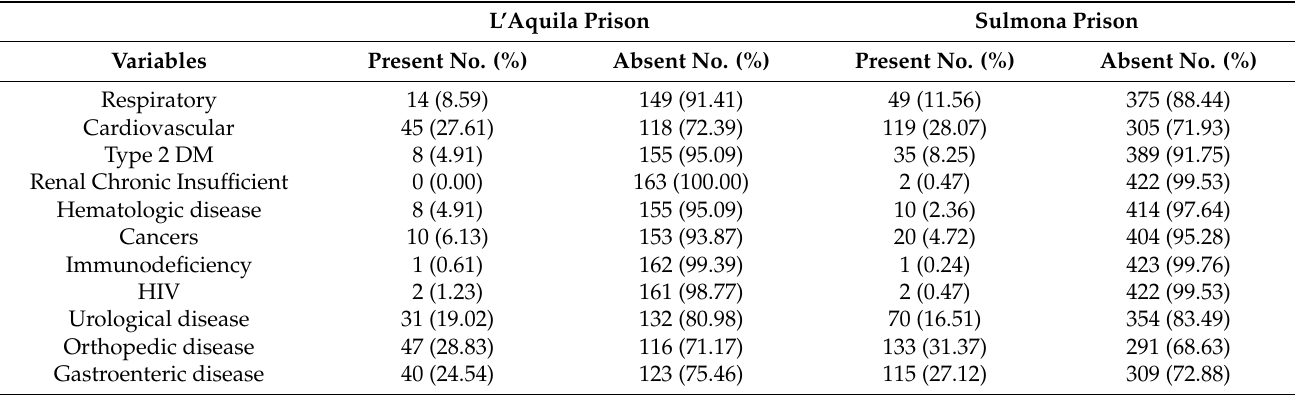
Table 1. Distribution of